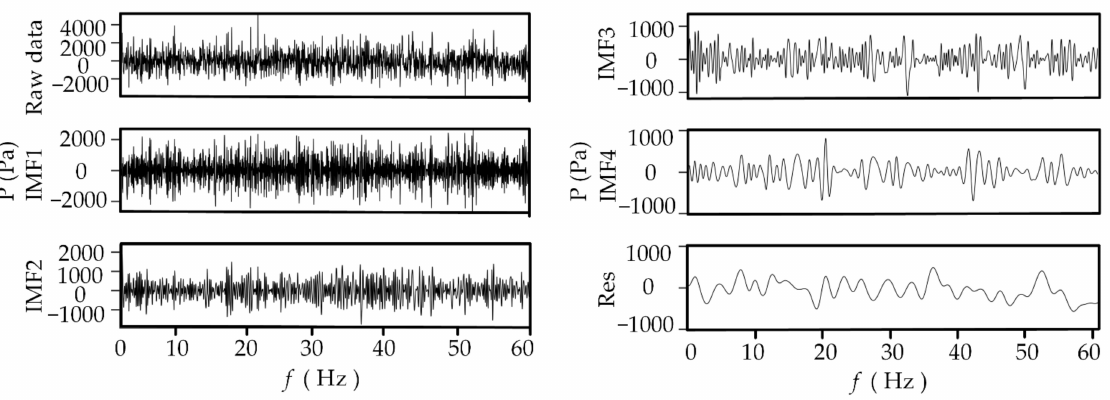
Figure 5. EMD decomposition